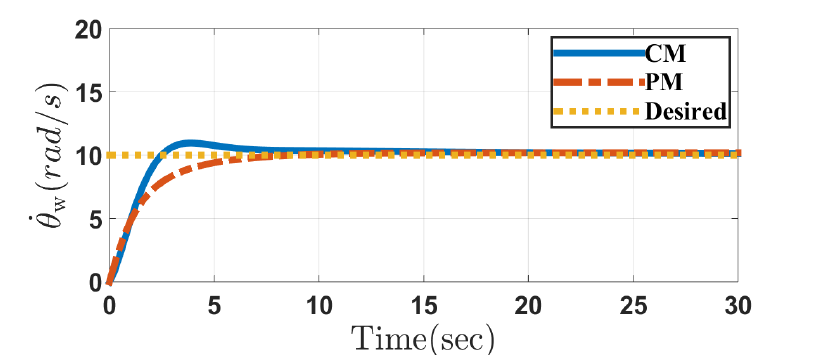
Figure 14. Wheel angular velocity of the system in the conventional method (CM) and the proposed method (PM) in Case 2.